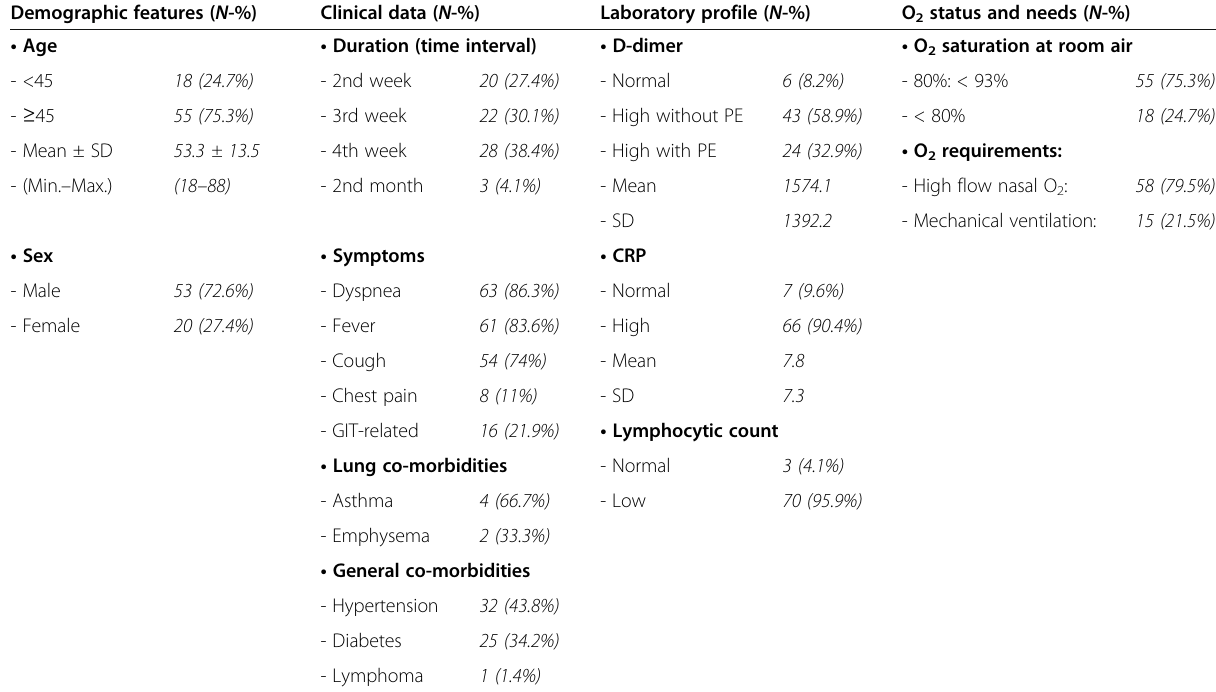
Table 1 Distribution of patients according to demographic features, clinico-laboratory data, O 2 requirements, and therapy Demographic features ( N -%) Clinical data ( N -%) Laboratory profile ( N -%) O 2 status and needs ( N